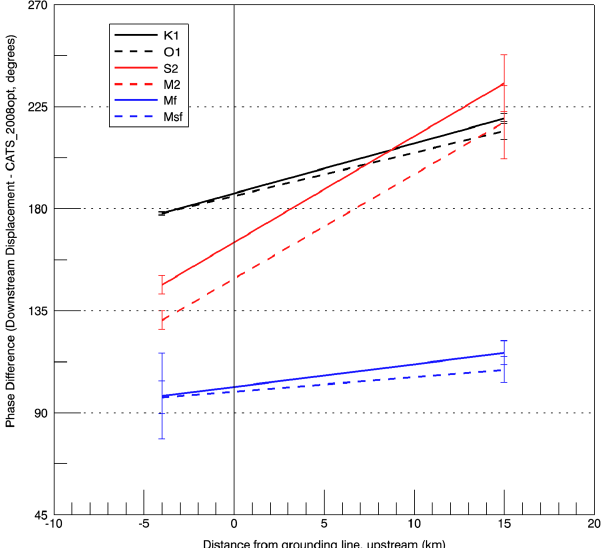
Fig. 5. Phase difference between measured detrended-horizontal displacements in downstream direction at GPS-2 and GPS-3 and modelled vertical ocean tides from the CATS 2008opt tidal simula- tion (Padman et al., 2008). Phase information for each tidal compo- nent is calculated using the t tide software package (Pawlowicz et al., 2002). Error bars are at 1 σ confidence